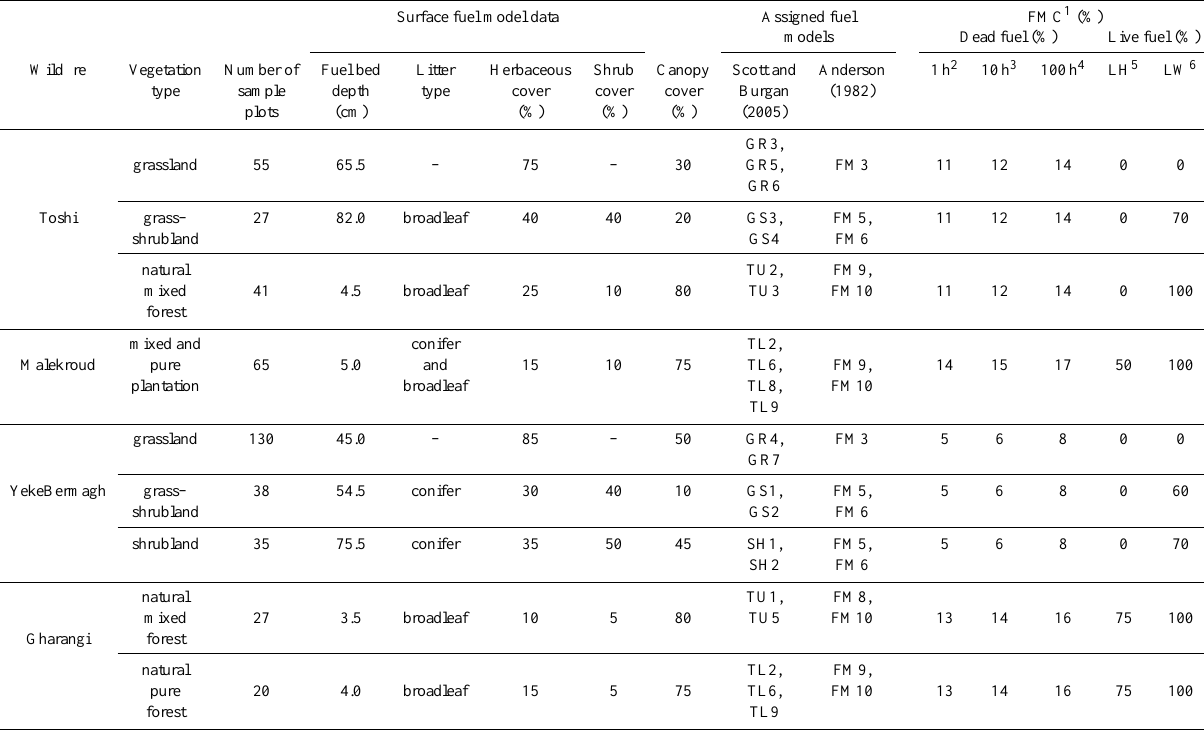
Table 3. Vegetation types and respective fuel models and fuel moisture parameters used in FARSITE